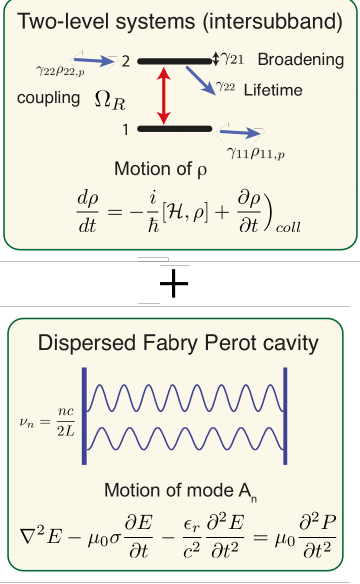
Figure 7: Schematic drawing showing the coupling between the optical Bloch equations, describing the motion of the density matrix and the Maxwell equation for the optical modes